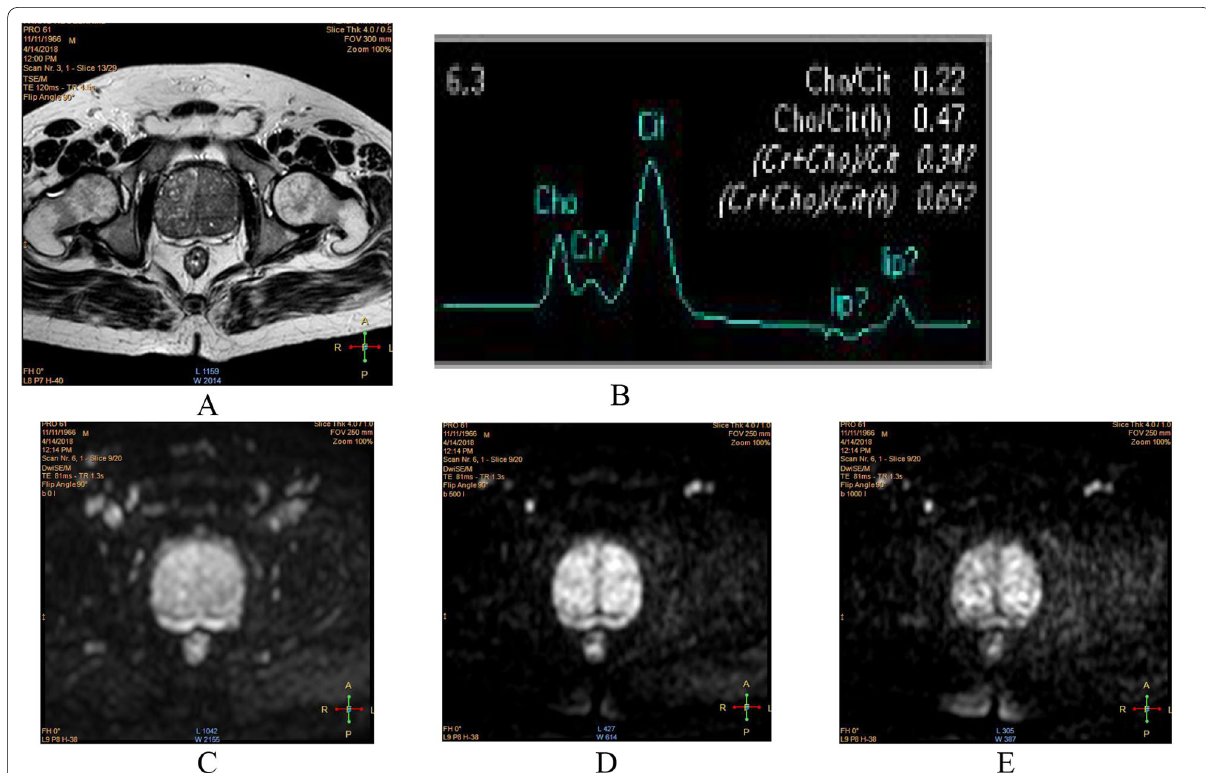
Fig. 1 61-year-old male patient presented with dysuria, A: Axial T2WI reveals hyperintense signal of both peripheral zones. B: MRS reveals spectral wave negative for malignancy. C, D and E: Diffusion weighted images at (b0, b500 and b1000 values) shows facilitated